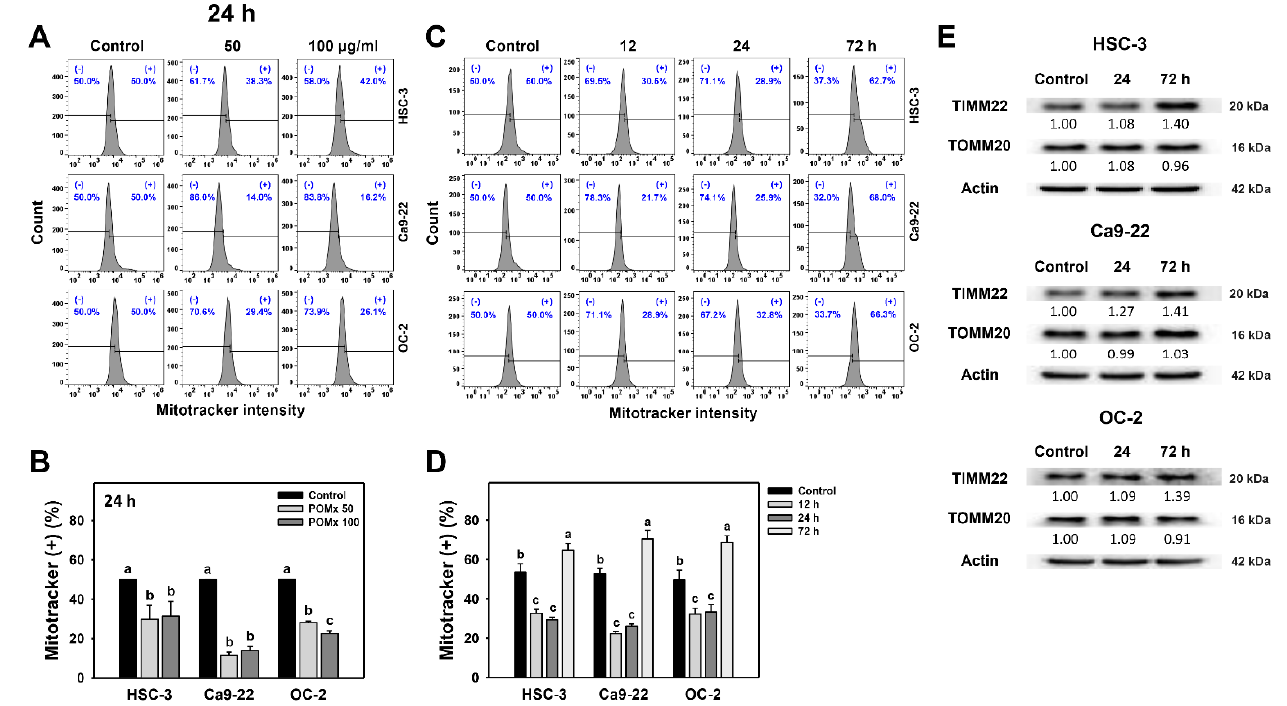
Figure 8. Mitochondrial mass of oral cancer cells after POMx incubation. ( A ) Dose-response to Mitotracker flow cytometry patterns. Cells (HSC-3, Ca9-22, and OC-2) were incubated with control, 50, and 100 μ g/mL of POMx (control, POMx 50, and POMx 100) for 24 h. The Mitotracker (+) population was defined on the right side of each panel. ( B ) Statistics for ( A ). ( C ) Time course to Mitotracker flow cytometry patterns. Cells were incubated with control and 100 μ g/mL of POMx for 0, 12, 24, and 72 h. ( D ) Statistics for ( C ). Treatments without overlapping low cases (a to c) are significantly different for the same cell lines. p < 0.05. Data, mean ± SD ( n = 3). ( E ) Western blotting for mitochondrial resident proteins for 24 and 72 h. Cells were incubated with control and 100 μ g/mL of POMx for 24 and 72 h.